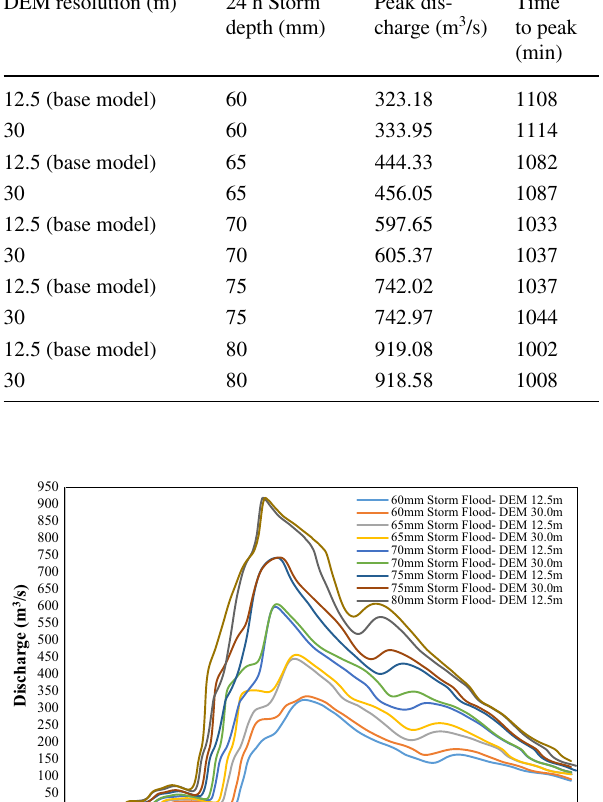
Table 5 Flood properties of calibrated GSSHA base model for five 24 h floods of 60–80 mm cumulative depths compared to hydrographs corresponding to GSSHA model by modeling all watercourses with a drainage area of larger than 5 km 2